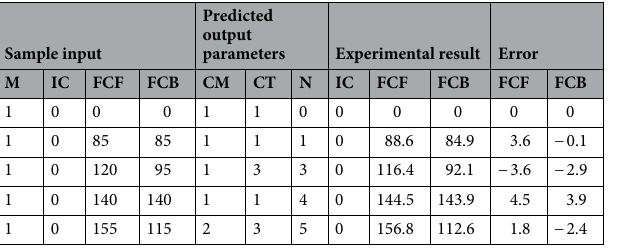
Table 3. Input and predicted output parameters from ML system, the experimental results obtained using the predicted parameters and the error.